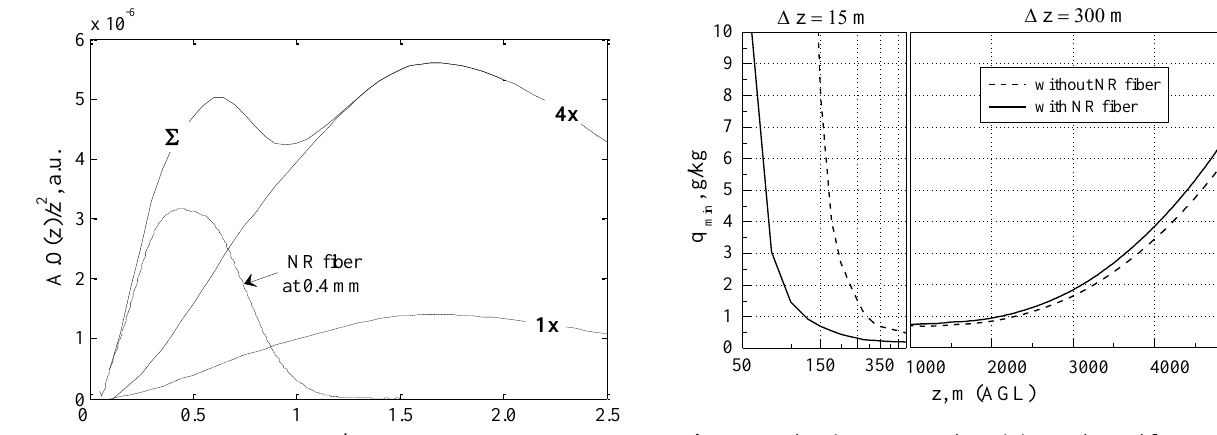
Fig. 7. NR fiber influence on the minimum detectable water vapor mixing ratio profiles (SNR = 10): averaging 30 min, 65 MHz sky background in the water vapor channel, molecular two-way attenu- ation from US standard atmosphere, aerosol two-way transmission assuming constant aerosol extinction at 550 nm of 0.11 up to 1.5 km with Angstr¨om coefficient of